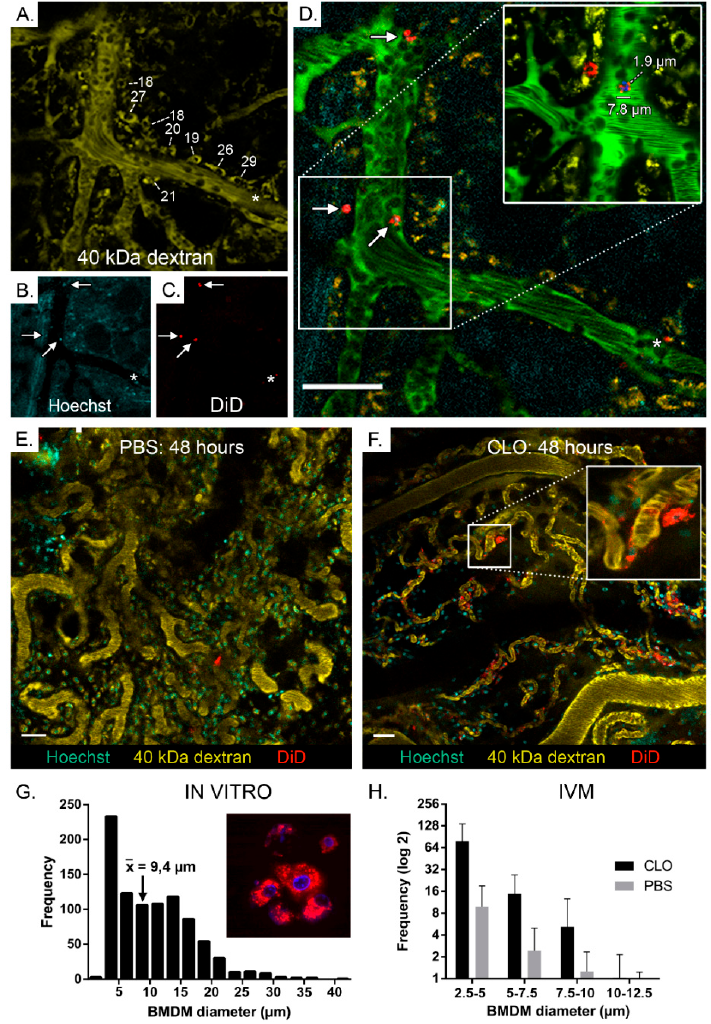
Figure 3. Depletion of the mononuclear phagocyte system increased the accumulation of BMDMs in the tumor interstitium. Mice were first pretreated with either PBS or CLO liposomes. After 24 h, 10 6 BMDMs that were labeled with both DiD (red) and Hoechst (blue) were injected in mice pretreated with CLO liposomes. After 60–90 min, the appearance of these double labeled BMDMs (white arrows in ( A – D ) in the tumor microenvironment was imaged by intravital microscopy. The insert in panel D demonstrates that non-uniformly labeled BMDMs can appear as small fluorescent speckles. The used labeling strategy allows separation of injected Hoechst/DiD-positive BMDMs (7.8 µm) from larger (18–29 µm) 40 kDa TMR-dextran-positive endogenous phagocytes (yellow). The white numbers in panel A represent the long diameter (in µm) of several endogenous macrophages lining the blood vessels. The asterisk in panels A–D shows an endogenous phagocyte suspected of engulfing DiD-labeled cell fragments (See also Supplementary video S3). Panel D was obtained by merging panels ( A – C ) with an additional layer of 2 MDa FITC-dextran (green) to delineate the blood vessels. ( G ) Size distribution of cultured DiD-labeled BMDMs. BMDMs were labeled with DiD and after 2 days of culture, confocal fluorescence images were taken and the size distribution of the cells was analyzed using Image J (bin size of 2.5 µm). A mean BMDM diameter of 9.4 µm was determined and fluorescent particles smaller than 2.5 µm were identified as background noise. ( H ) The size distribution of exogenously administered BMDMs that arrived in the tumor was quantified by automated particle counting on IVM images such as panels ( E ) and ( F ) . The data clearly show an increased accumulation of BMDMs in tumors of mice that were pretreated with CLO liposomes. Scale bars: 50 µm; the error bars represent standard deviation, n = 3.